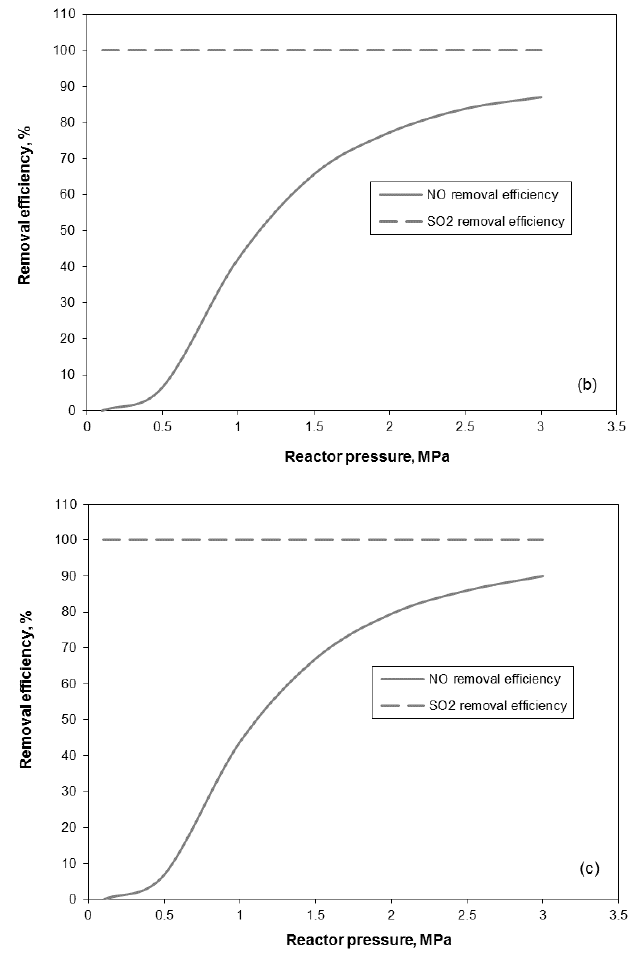
Figure 5. SO 2 and NO removal efficiency vs. scrubber pressure (H = 5 m): ( a ) Packed-bed column with Raschig super-Rings; ( b ) Packed-bed column with I-Rings; ( c ) Packed-bed column with Pall-Rings.